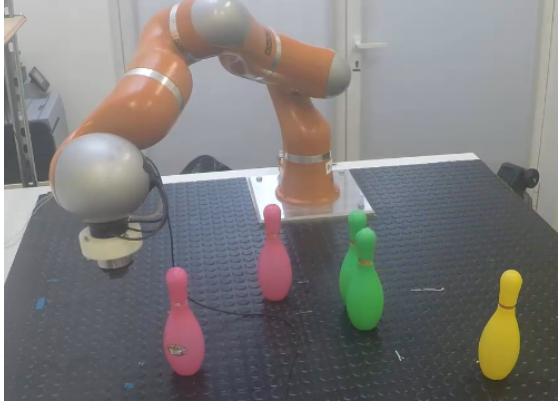
Figure 3. Experimental